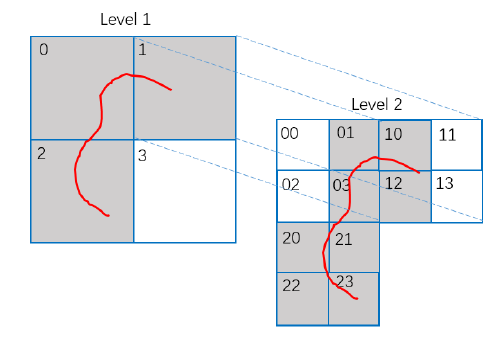
Figure 6. Tile construction process after